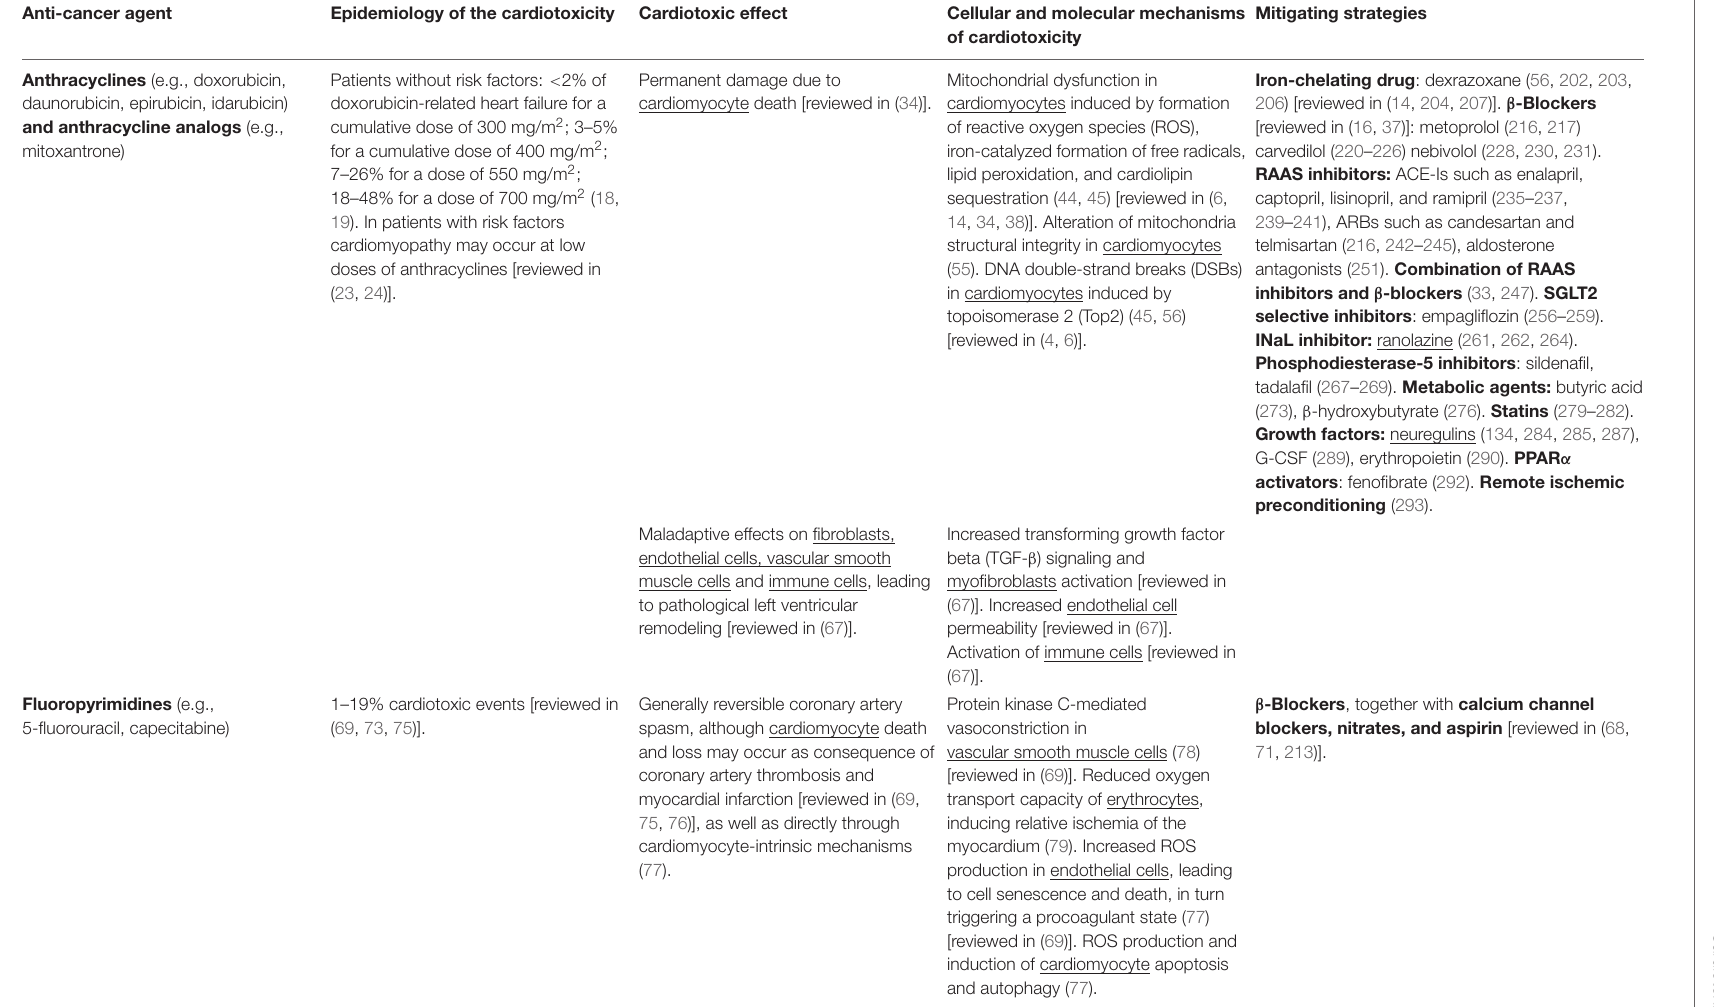
TABLE 1 | Main features and mechanisms of cardiotoxic side effect of chemotherapies and targeted therapies along with mitigating